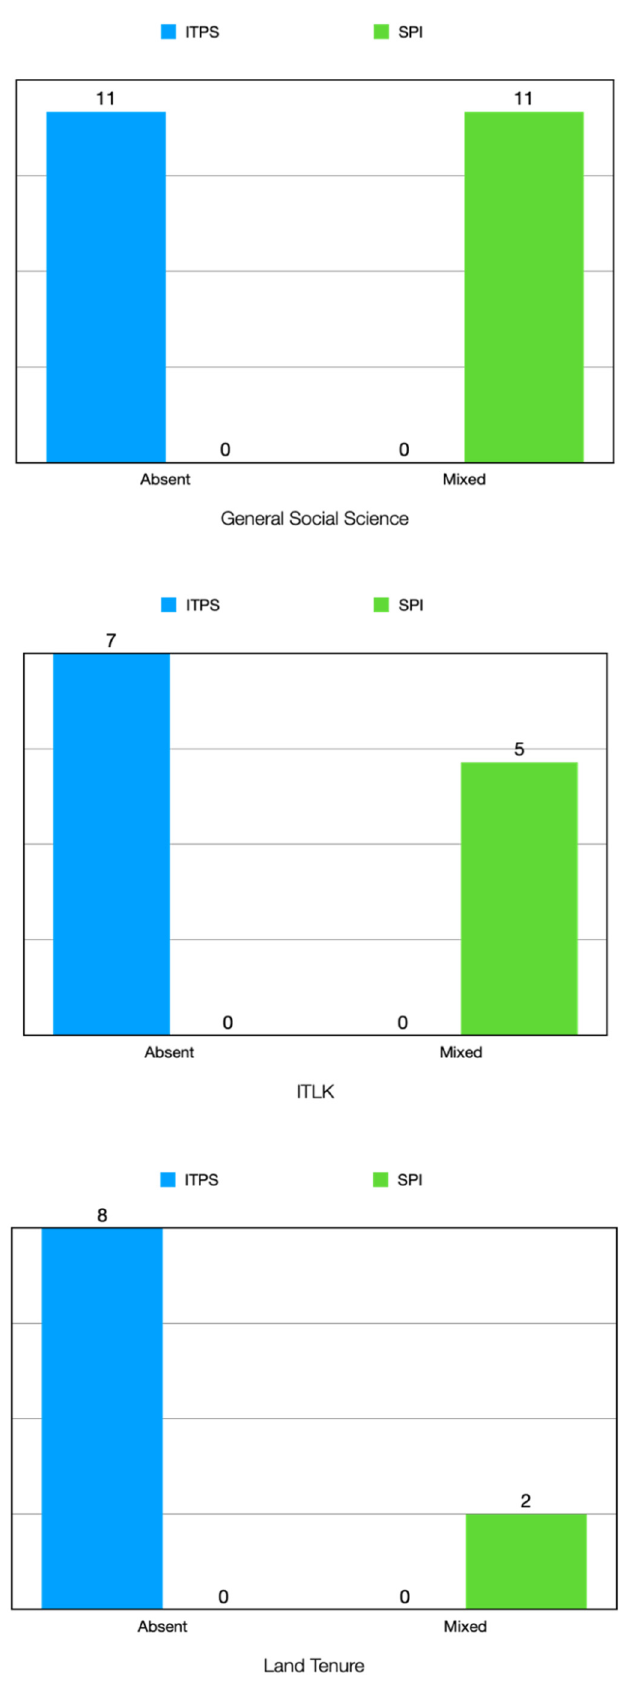
Figure 2. Breakdown of the categories ‘general social science’, ‘ITLK’ and ‘land tenure’.